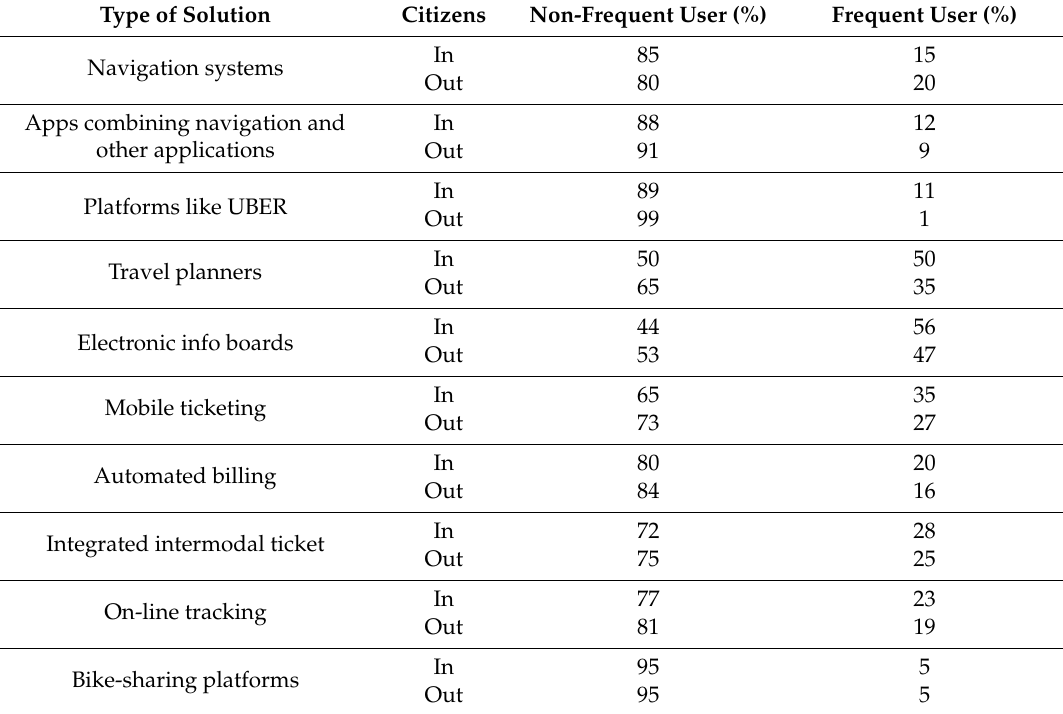
Table 3. The relationship between specific ICT use and place of residence (RQ4).